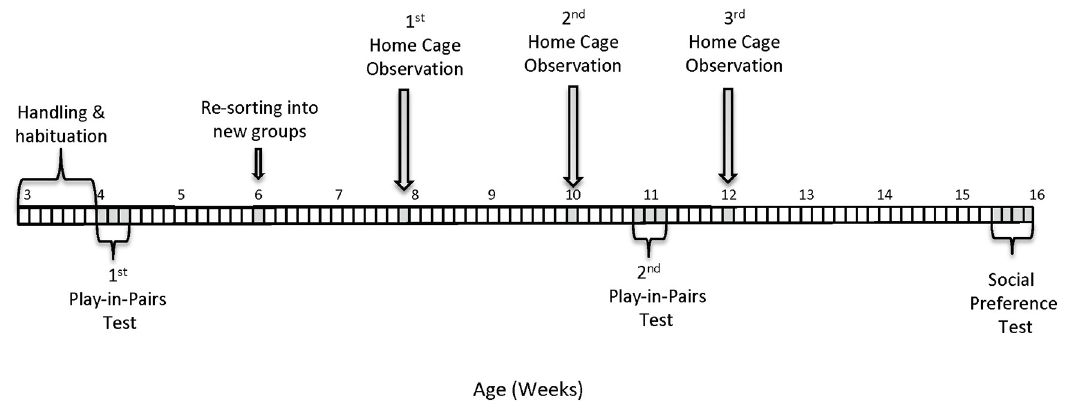
Fig 1. Experimental